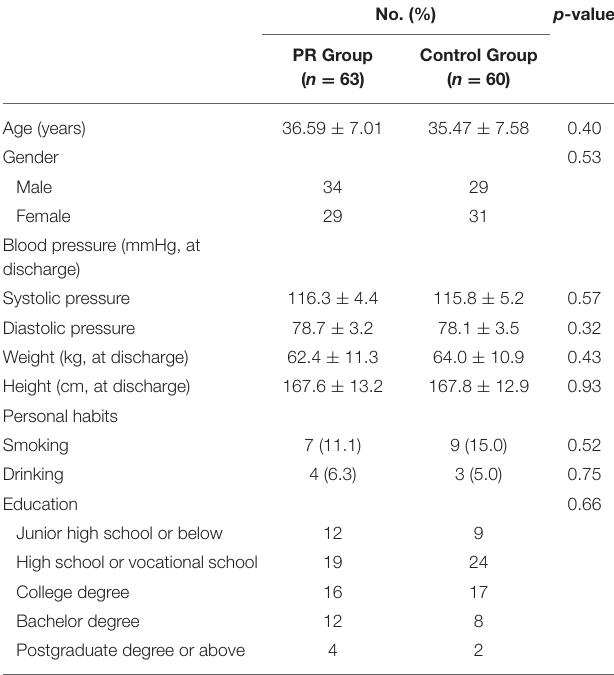
TABLE 1 | General characteristics in PR and control